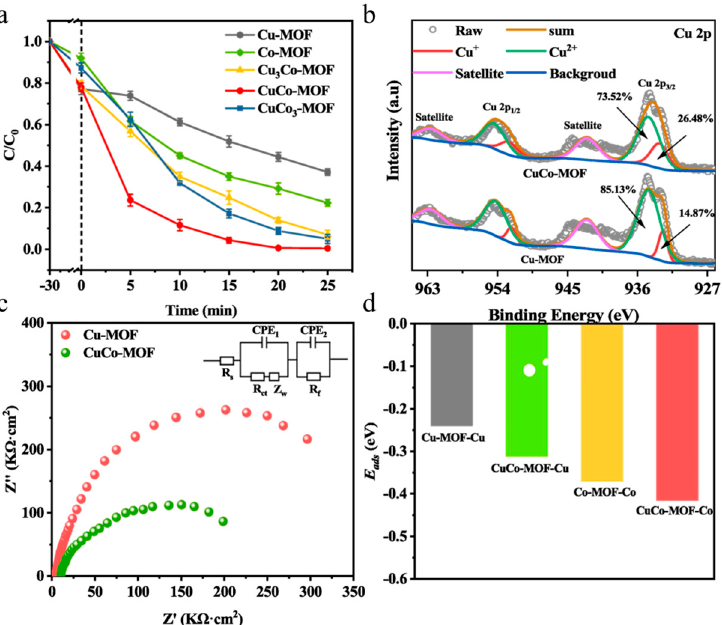
Figure 10. ( a ) Degradation efficiency curves of different materials for NIM; ( b ) Cu 2p XPS spectra of CuCo-MOF and Cu-MOF; ( c ) Nyquist plots of CuCo-MOF and Cu-MOF; and ( d ) adsorption energy of PMS on metal sites of different structures. Adapted with permission from Ref. [78], 2023, Elsevier. Zhang et al. [79] synthesized MIL-125(Ti) -NH 2 -Sal-Fe, a highly efficient